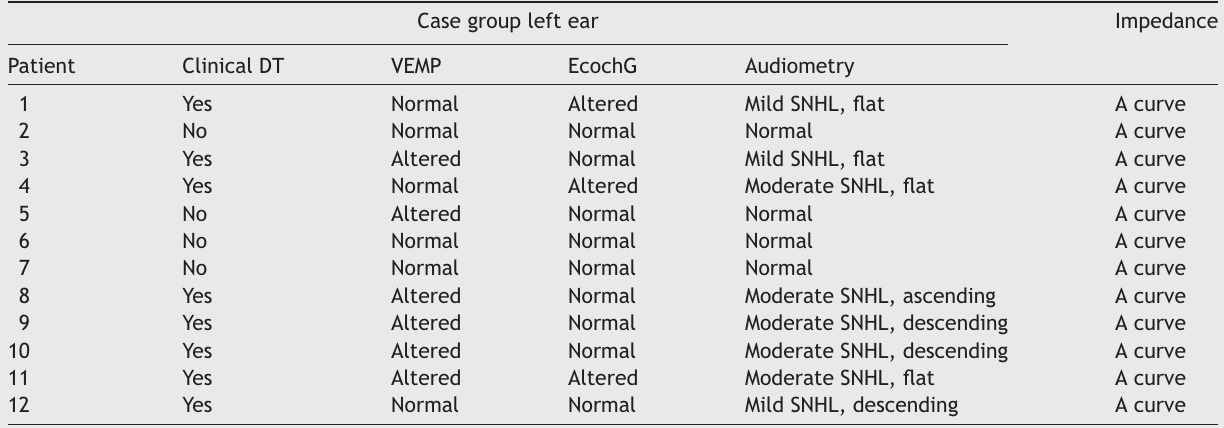
Individual results of the left ear in the case group.